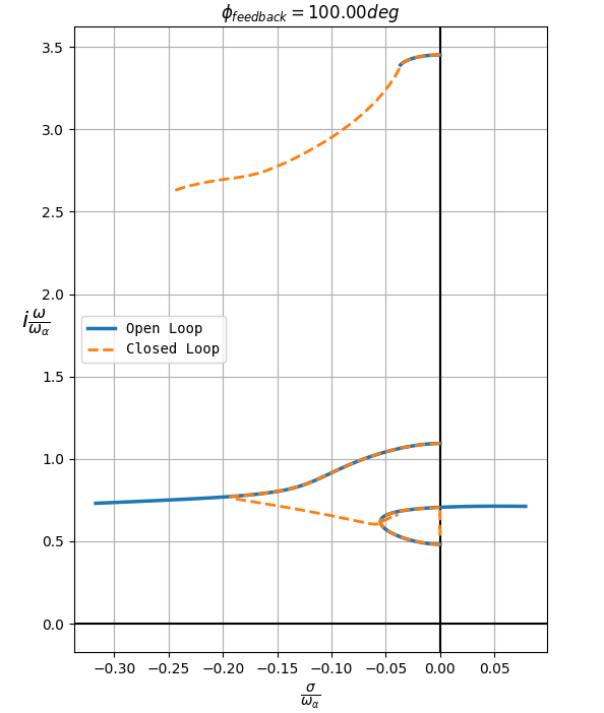
Figure 10. Root locus of a three dof airfoil in an incompressible flow in a closed loop to prevent